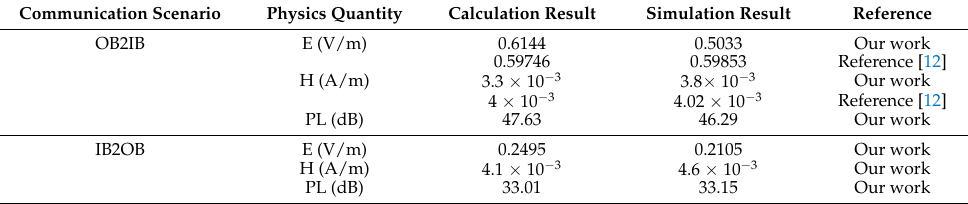
Table 3. Comparative study between calculation and simulation results on different communication scenarios at frequency of 2.45 GHz.